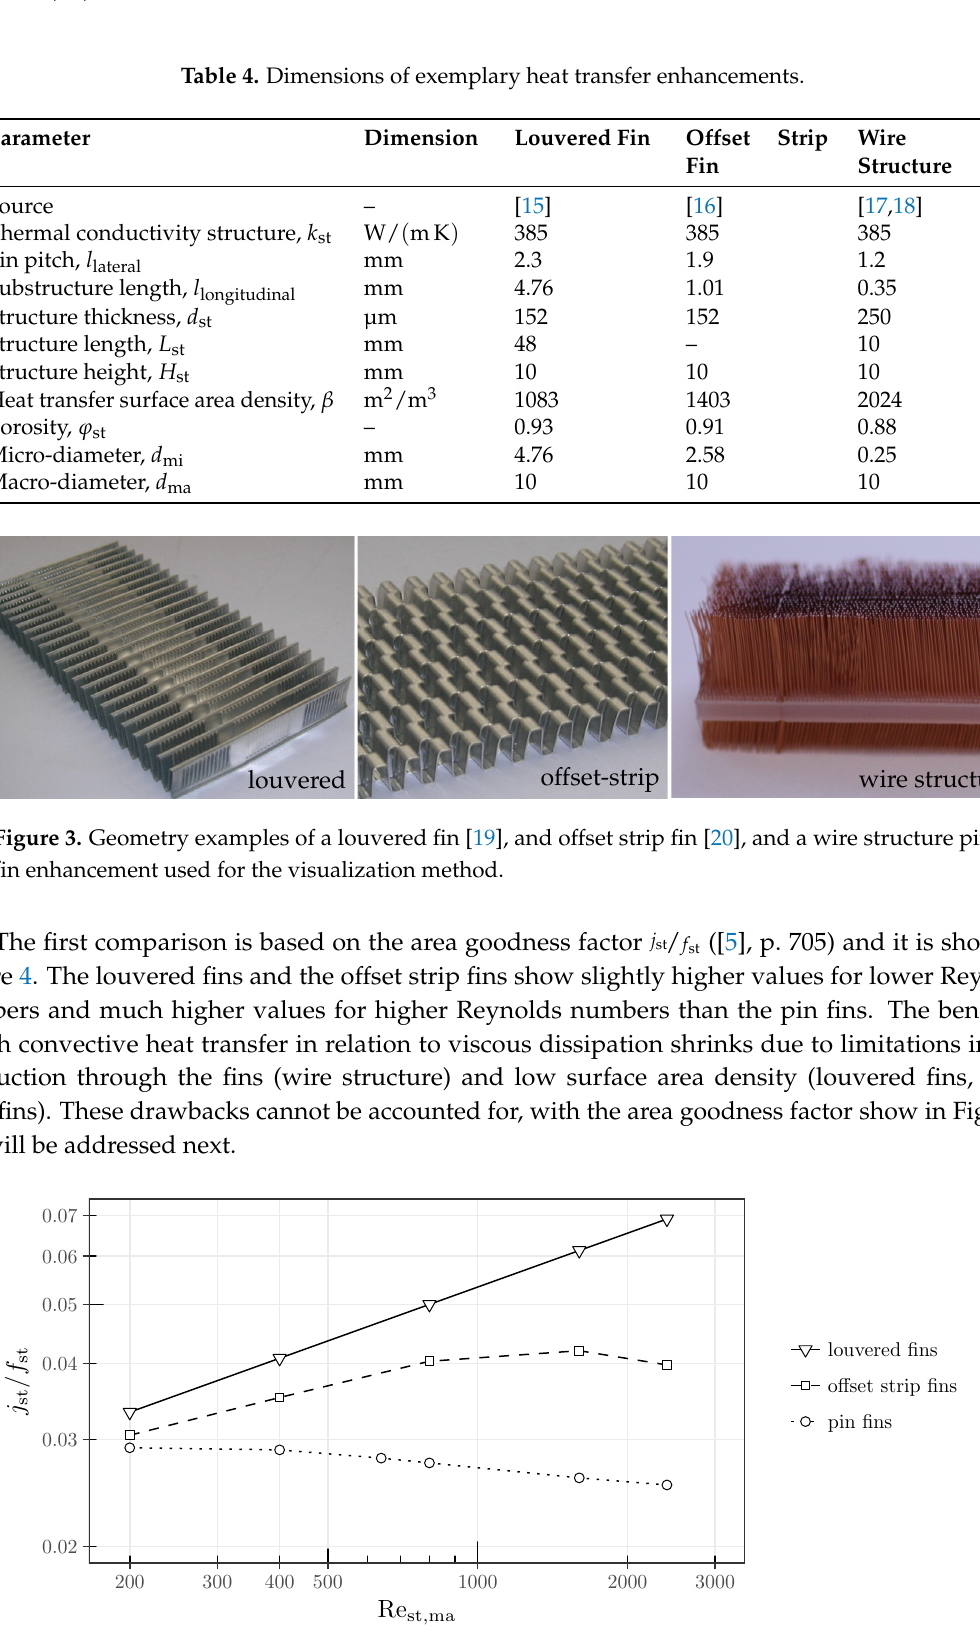
Figure 4. Ratio of Colburn factor j st and Fanning friction factor f st versus Reynolds number for different